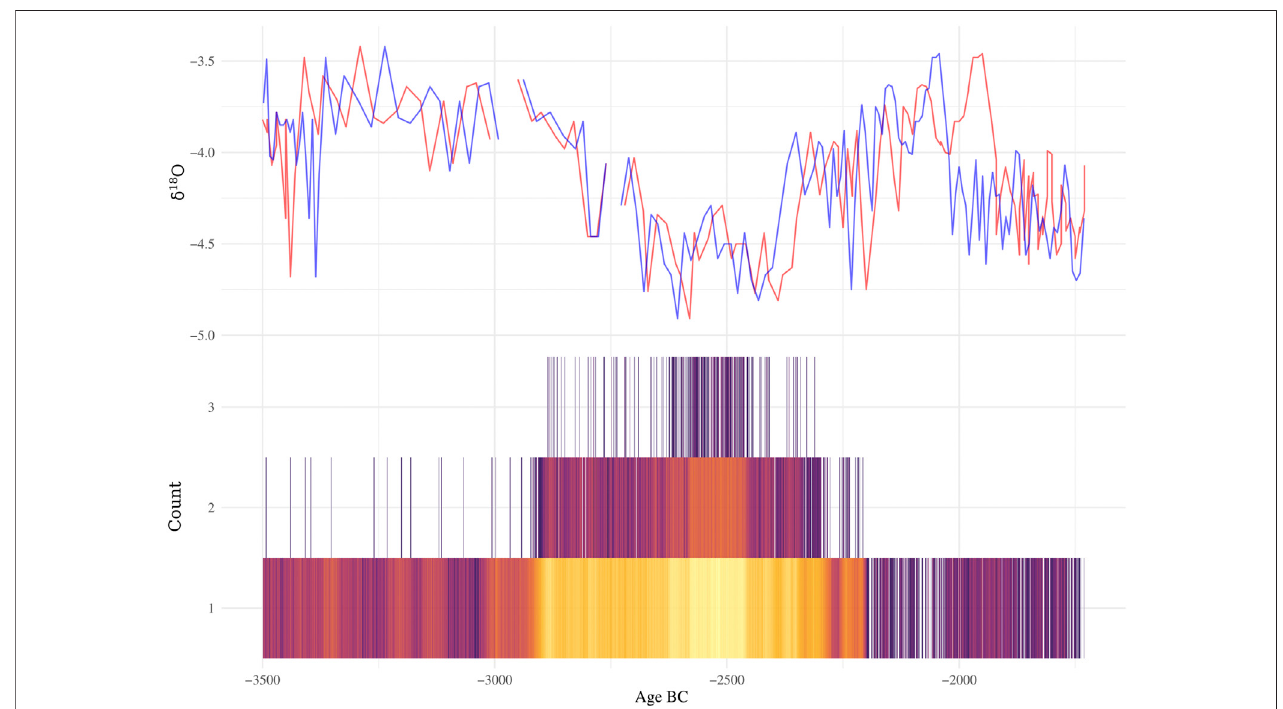
FIGURE 10 | As for Figure 9 , but only including radiocarbon age estimates from the Xag ħ ra Circle.